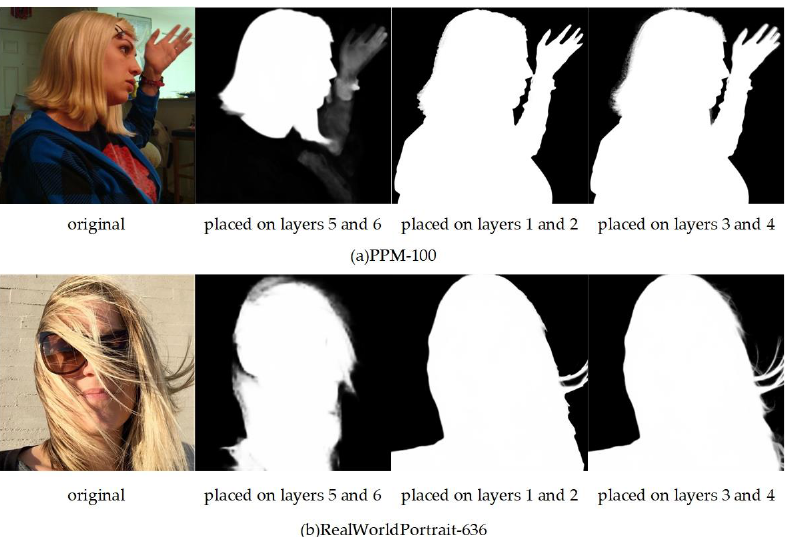
Figure 5. Experimental effects of different layers of contour sharpness refinement networks placed on different datasets.